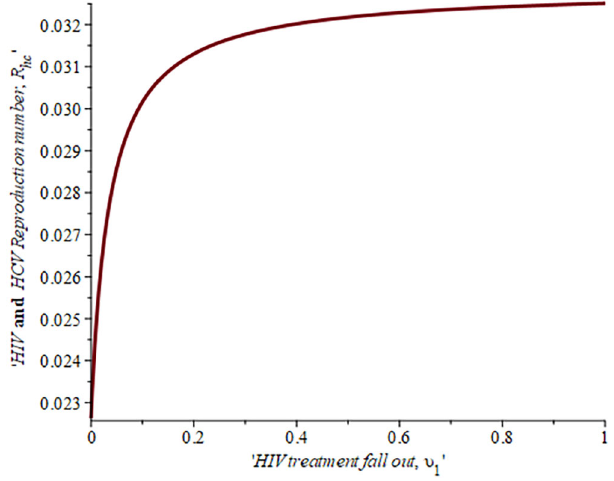
Ref. 52. Figure 7 shows the impact of fall-out on the dually infected with HIV-HCV reproduction number. As the proportion of the fallout population increases HIV reproduction also increases. For example, if the proportion of the population that fall-out of treatment is 16 : 4 % , R eH ¼ 0 : 04, if υ ¼ 30 % , R eH ¼ 0 : 042and when υ ¼ 50 % R eH ¼ 0 : 044, this supports the data fitting done by Ref. 52.